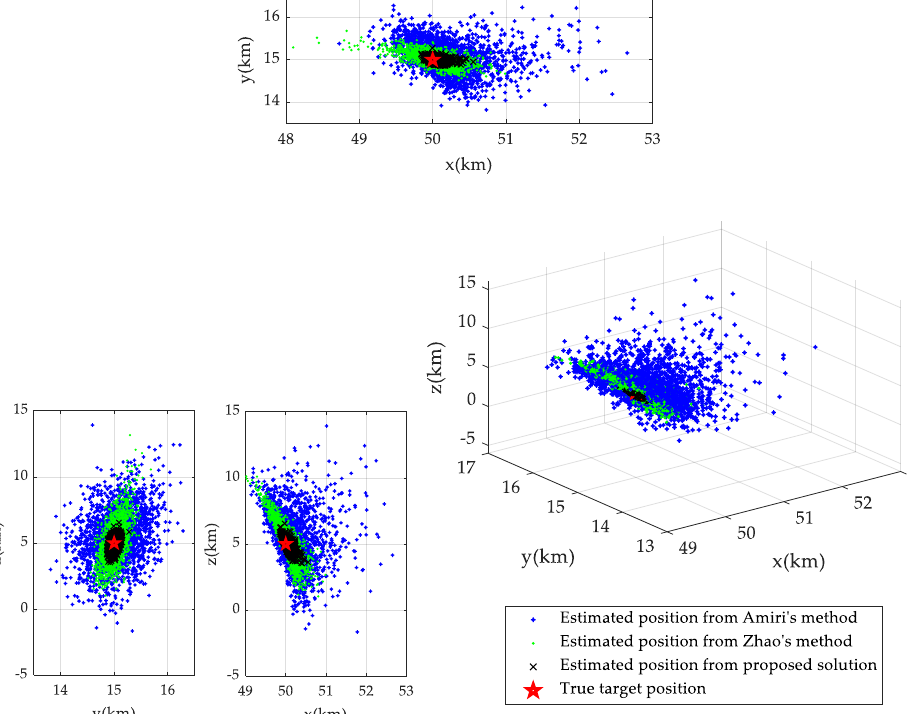
Figure 4. Scatter plots of estimated positions from different methods.